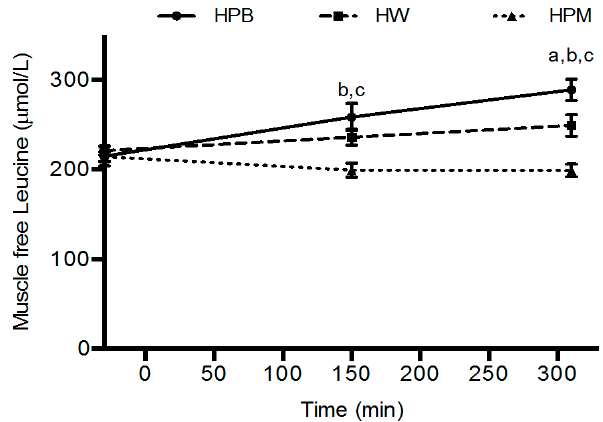
Figure 5. Mean ± SEM muscle-free leucine concentrations, n = 18. a HPB significantly different from HW, p < 0.01. b HPB significantly different from HPM, p < 0.01. c HW significantly different from HPM, p < 0.01. Data were analyzed using linear mixed-effects models with a time-treatment interaction and treatment order, age and muscle-free leucine concentrations at baseline as fixed effects and with subject-specific random effects. HPB, hydrolyzed porcine blood protein; HPM, hydrolyzed porcine